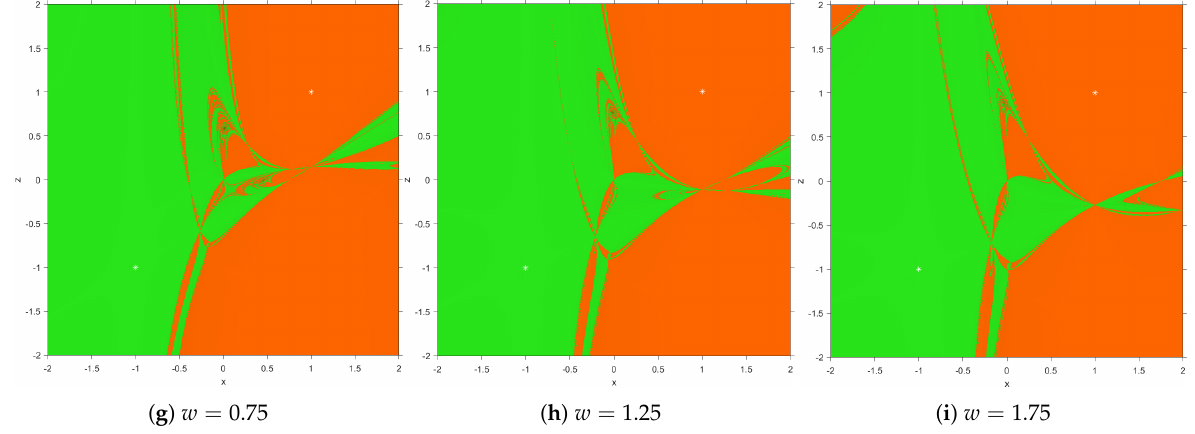
Figure 1. Dynamical planes of TM rational operator on p ( x ) , for m = 1.